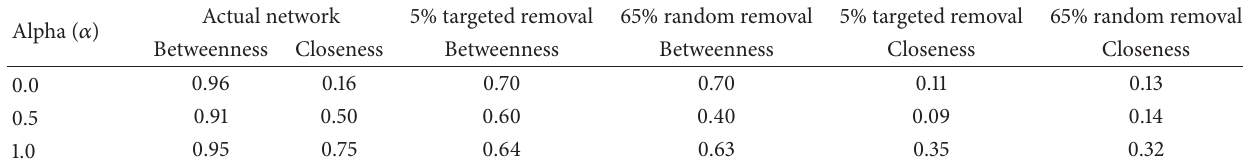
Table 5: Actual network versus 5% targeted and random removal of links up to 65%.